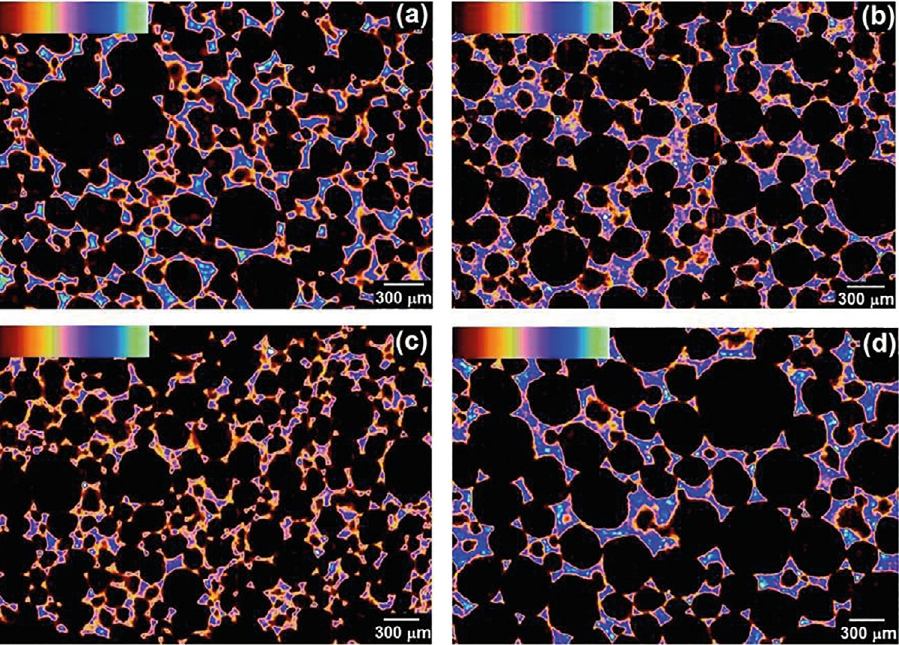
O – 95/5; (c) β-TCP/Al 2 3